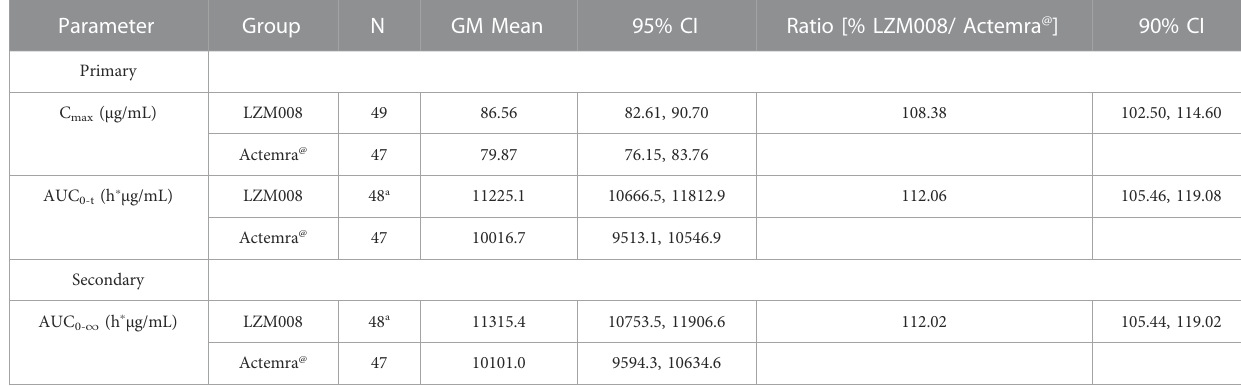
TABLE 3 Statistical analysis of C max , AUC 0-t , and AUC 0- ∞ of LZM008 and ACTEMRA ® .